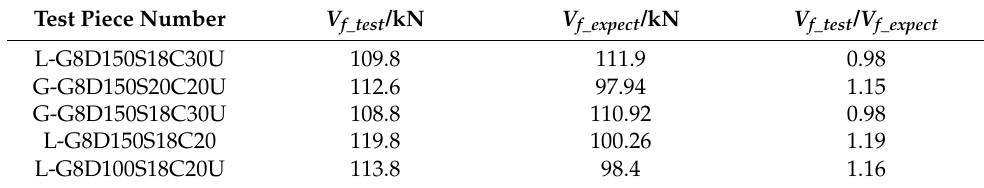
Table 10. Comparison of the shear-bearing capacity test value and the theoretical